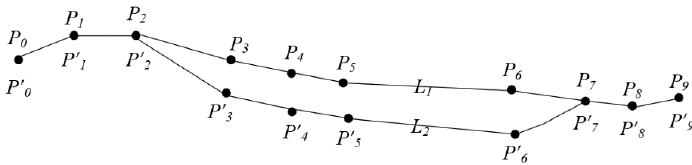
Figure 10. Connection rules of top border and bottom border of the lens.